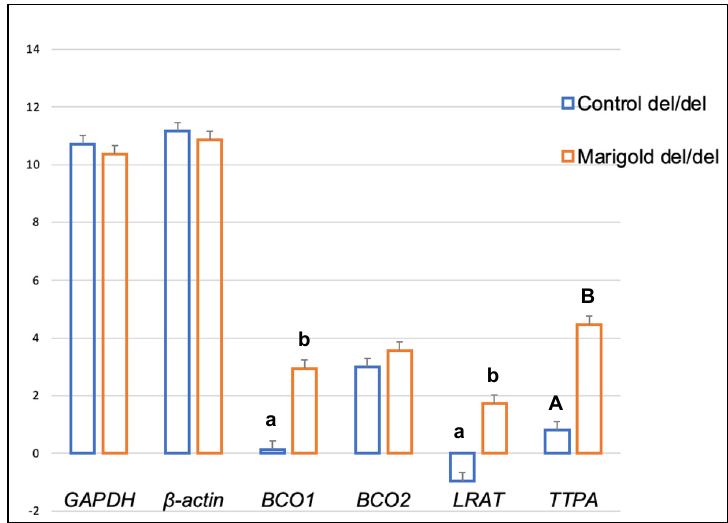
Figure 4. Relative BCO1 , BCO2 , LRAT, and TTPA mRNA levels (log2 abundance) in the perirenal fat of rabbits with the del/del genotype at codon 248 of the BCO2 gene, fed different diets (control diet vs. a diet with the addition of Aztec marigold flower extract). GAPDH and ß ‐ actin were used as reference genes. Data represent posterior means (expressed as arbitrary units) ± SEM (standard error of the mean). Means followed by the different superscripts (A, B) differ highly significantly ( p ≤ 0.01). Means followed by the different superscripts (a, b) differ significantly ( p ≤ 0.05). Table 1. Content of selected compounds in the perirenal fat ( μ g/g) of rabbits (mean SD). .